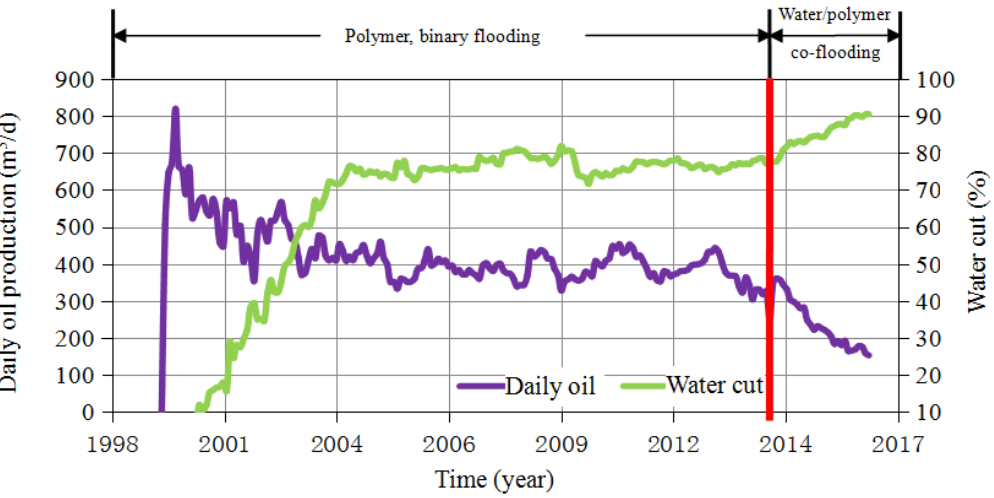
Figure 2. The daily oil production and water cut change law of old wells.